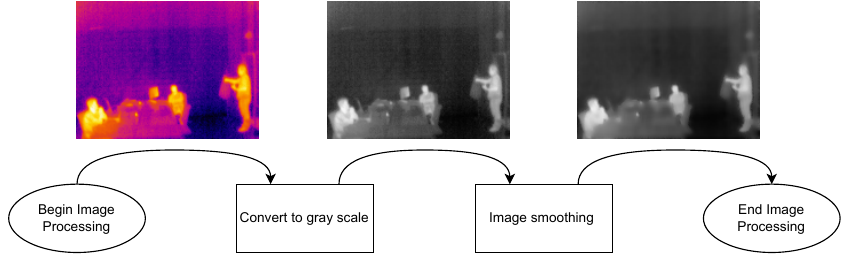
Figure 6. Steps performed for processing thermal images.